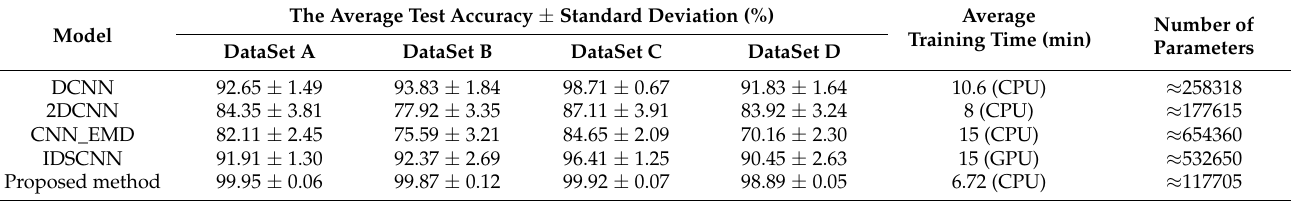
Table 5. Performance analysis of comparative